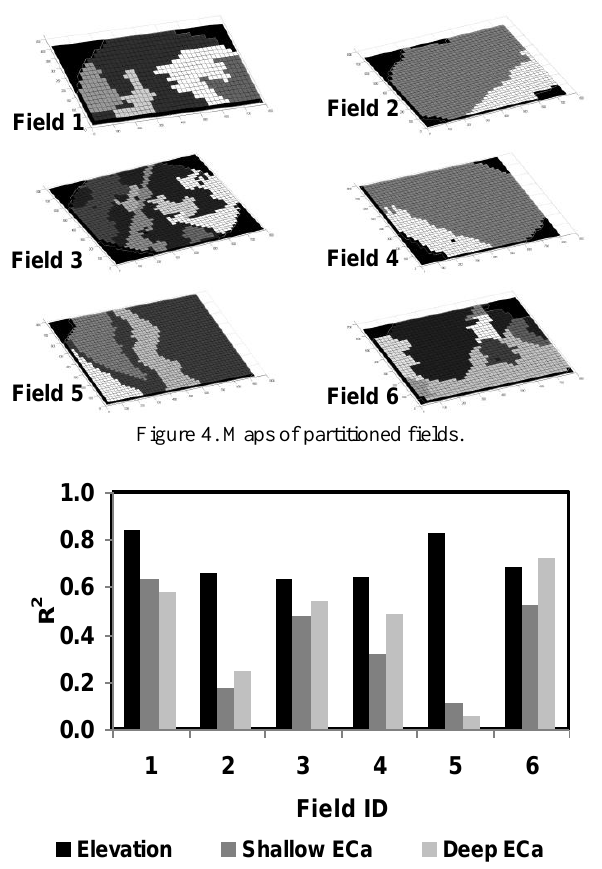
Figure 5. R 2 values for three data layers used to partition the six experimental fields.